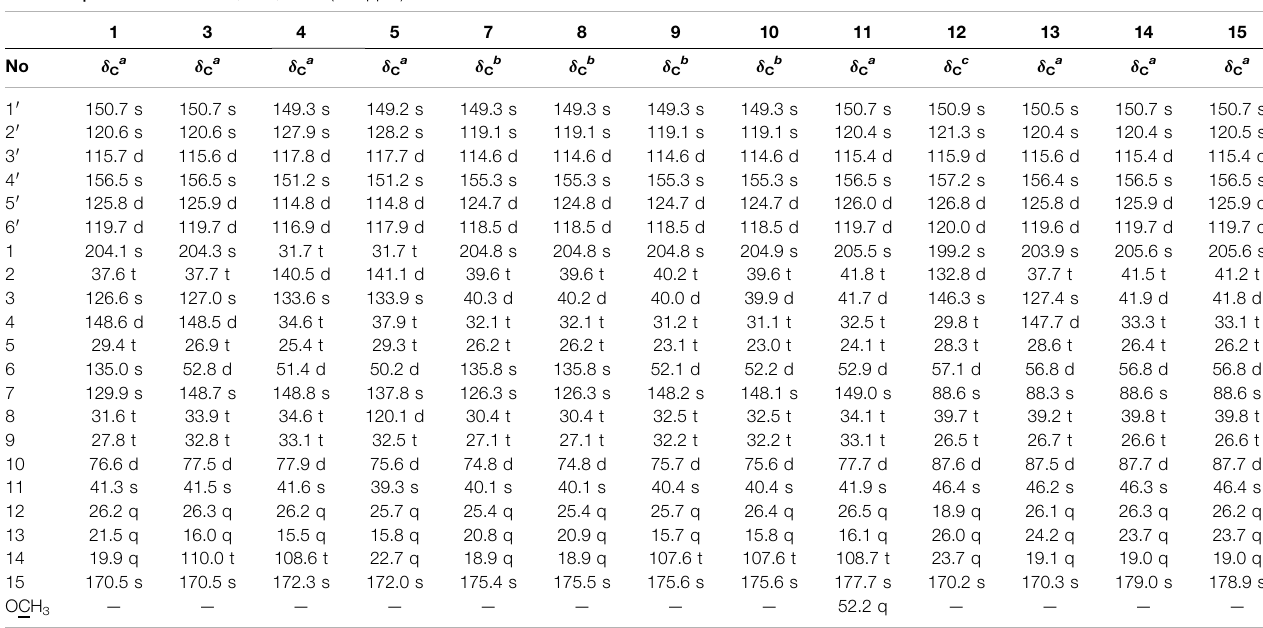
TABLE 2 | 13 C NMR data of 1 , 3 – 5 , 7 – 15 ( δ in